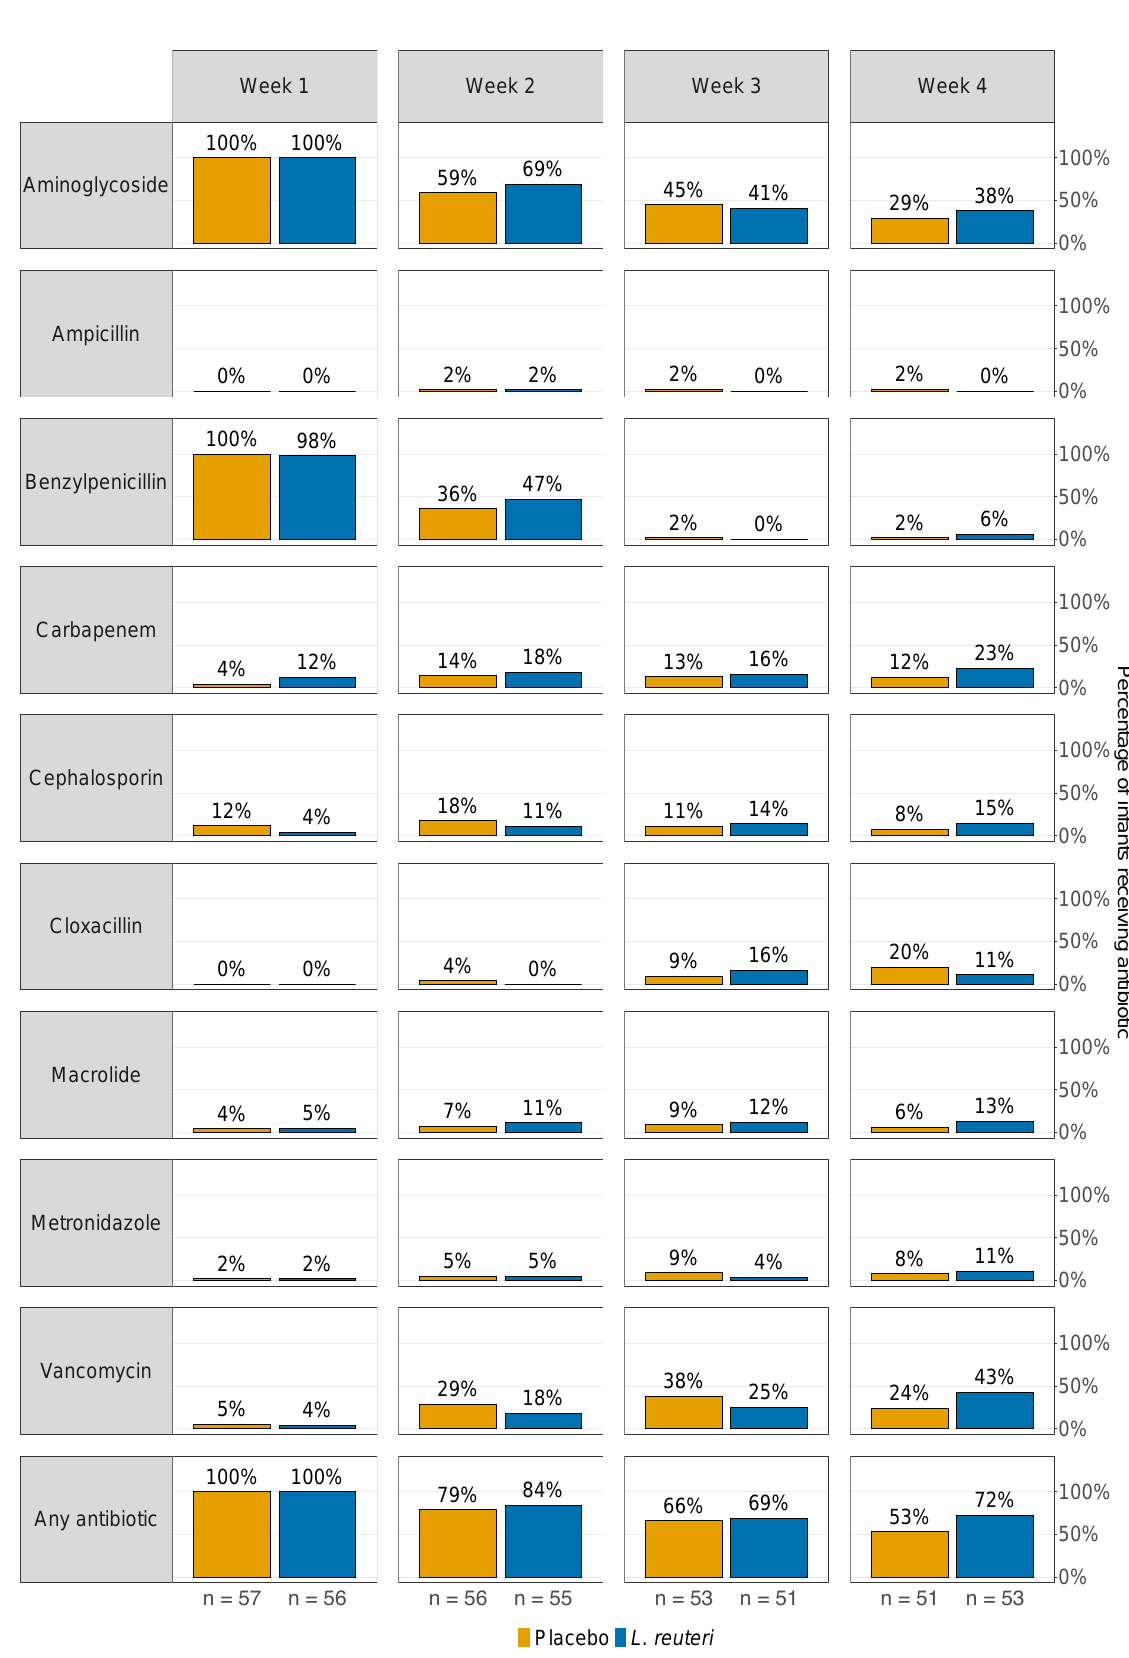
Figure 3. Antibiotic treatment in the L. reuteri -supplemented and placebo group. Bars show antibiotic treatment rates (in %) for placebo (yellow) and L. reuteri -supplemented (blue) extremely preterm ELBW infants, who were treated with the specified antibiotics for at least one day during the first, second, third, and fourth week of life. ELBW = extremely low birth